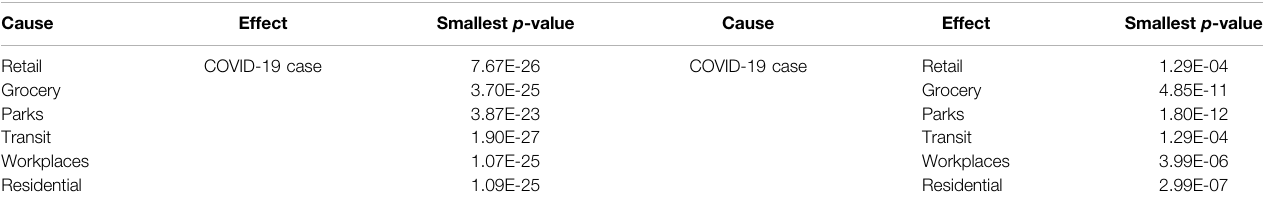
TABLE 6 | Lower bound of p -values for testing causation from Google mobility indexes to COVID-19 case and from COVID-19 case to Google mobility